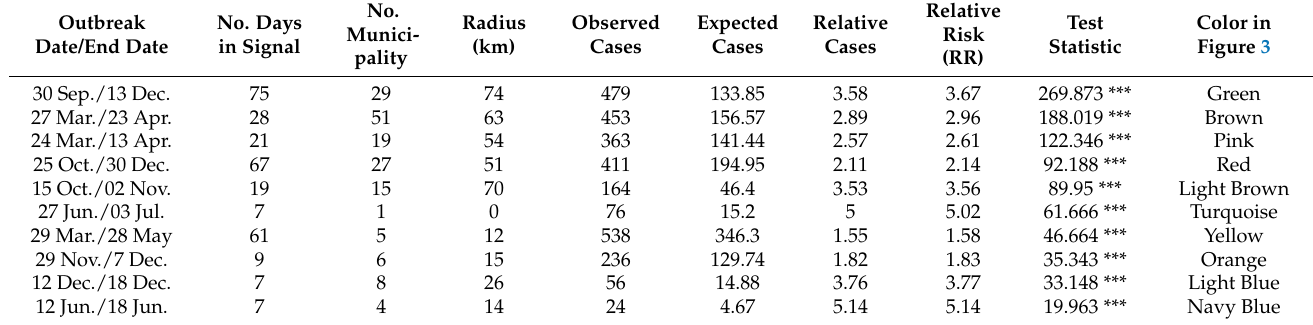
Table 2. Portuguese municipalities in space-time clusters between 3 March and 31 December 2020 and respective relative risks of COVID-19 infection among the elderly living in residential care